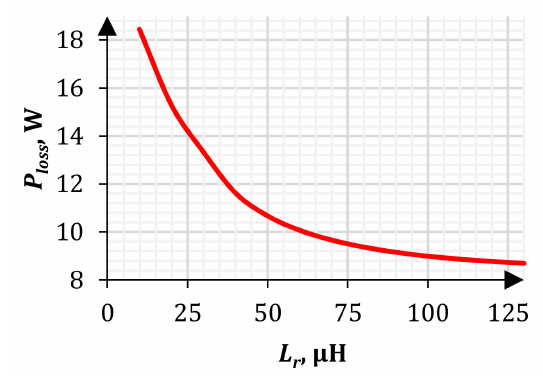
Figure 10. Dependence of the total power loss of the converter ( P loss ) on the resonance induc- tance